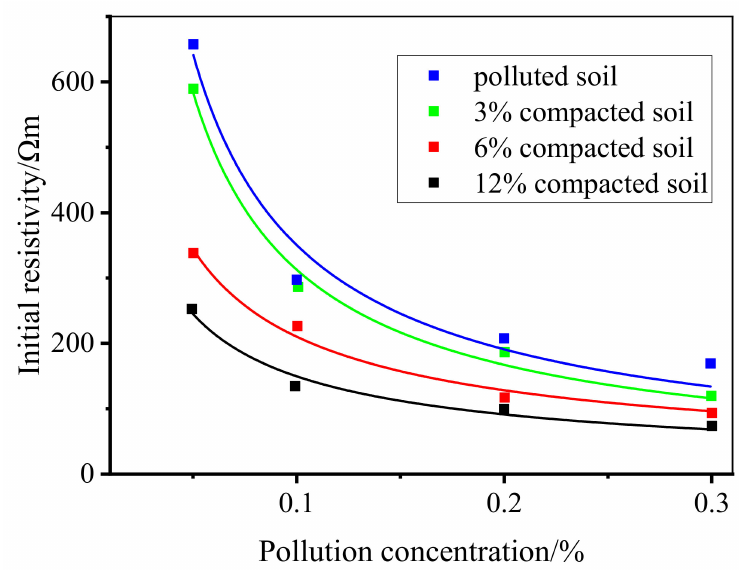
Figure 7. Relationship between different pollution concentrations and initial